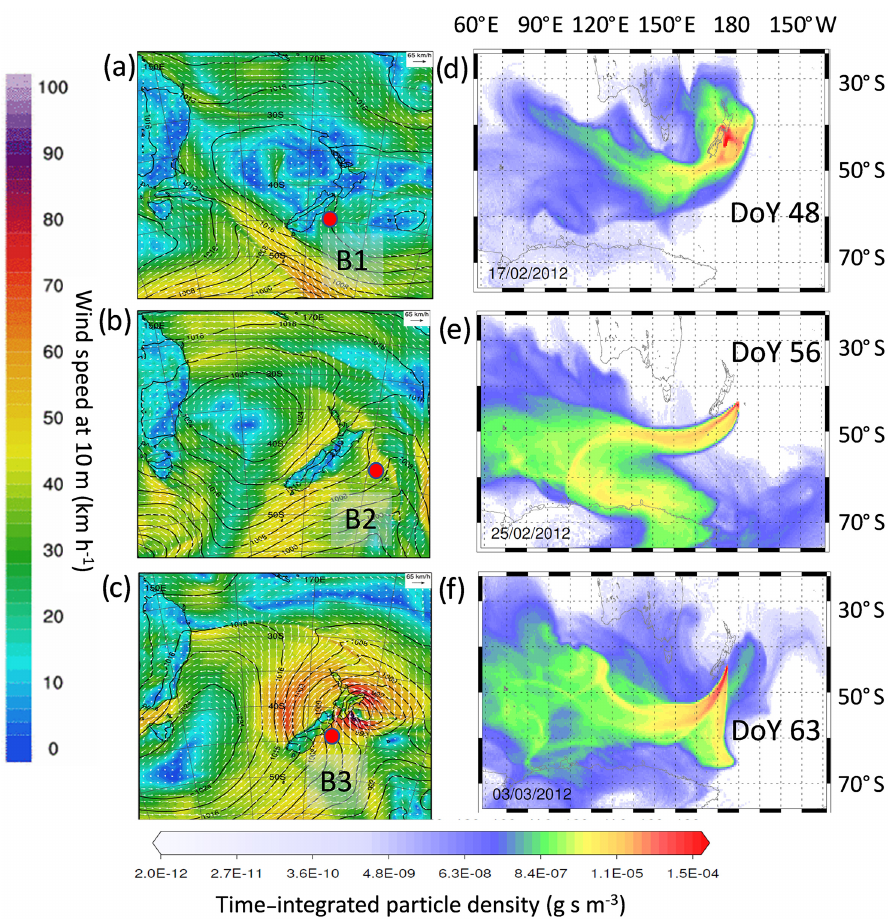
Figure 5. (a–c) Synoptic meteorology summary for each bloom period during the SOAP voyage. Surface pressure and wind plots (color scale to the left of panels a – c ) are derived from the New Zealand local area unified model NZLAM, with the bloom location indicated by a red dot. (d–f) Back-trajectory analyses for each bloom period during the SOAP voyage. This was calculated using the Lagrangian Numerical Atmospheric-dispersion Modelling Environment (NAME) for the lower atmosphere (0–100m) as time-integrated particle density (gsm − 3 ; color scale below figures). Each plot shows the back trajectory of eight “releases”, i.e., one every 3h over 24h for the actual ship